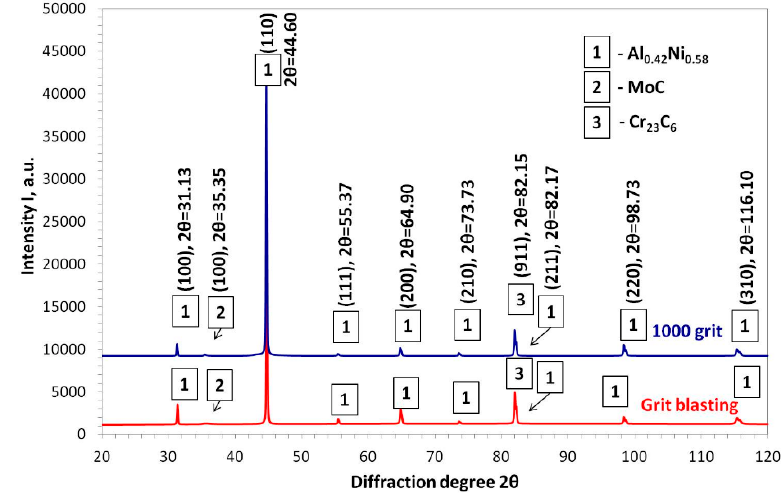
Figure 9. XRD patterns obtained from aluminized IN 625 with ground and grit-blasted surfaces in the as-received condition.